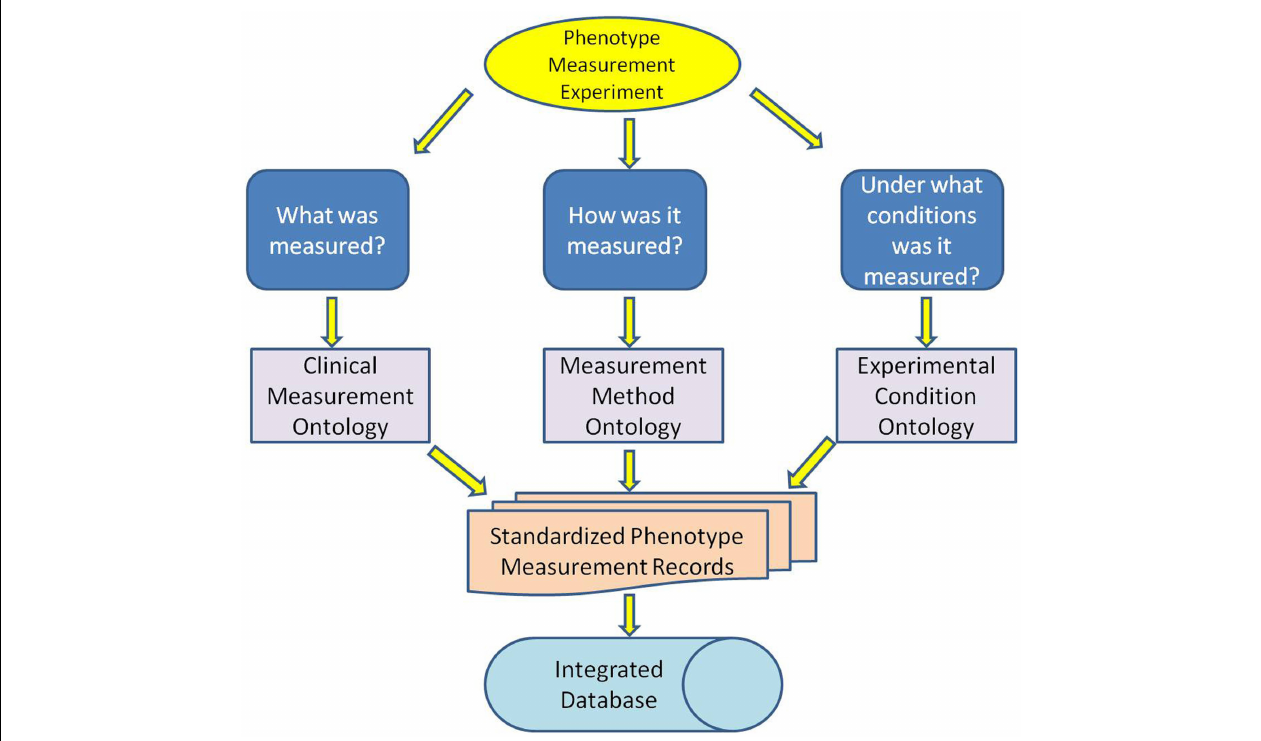
FIGURE 1 |Three ontologies were developed to standardize the three elements of a measurement record: what was measured, how it was measured and under what conditions it was measured.